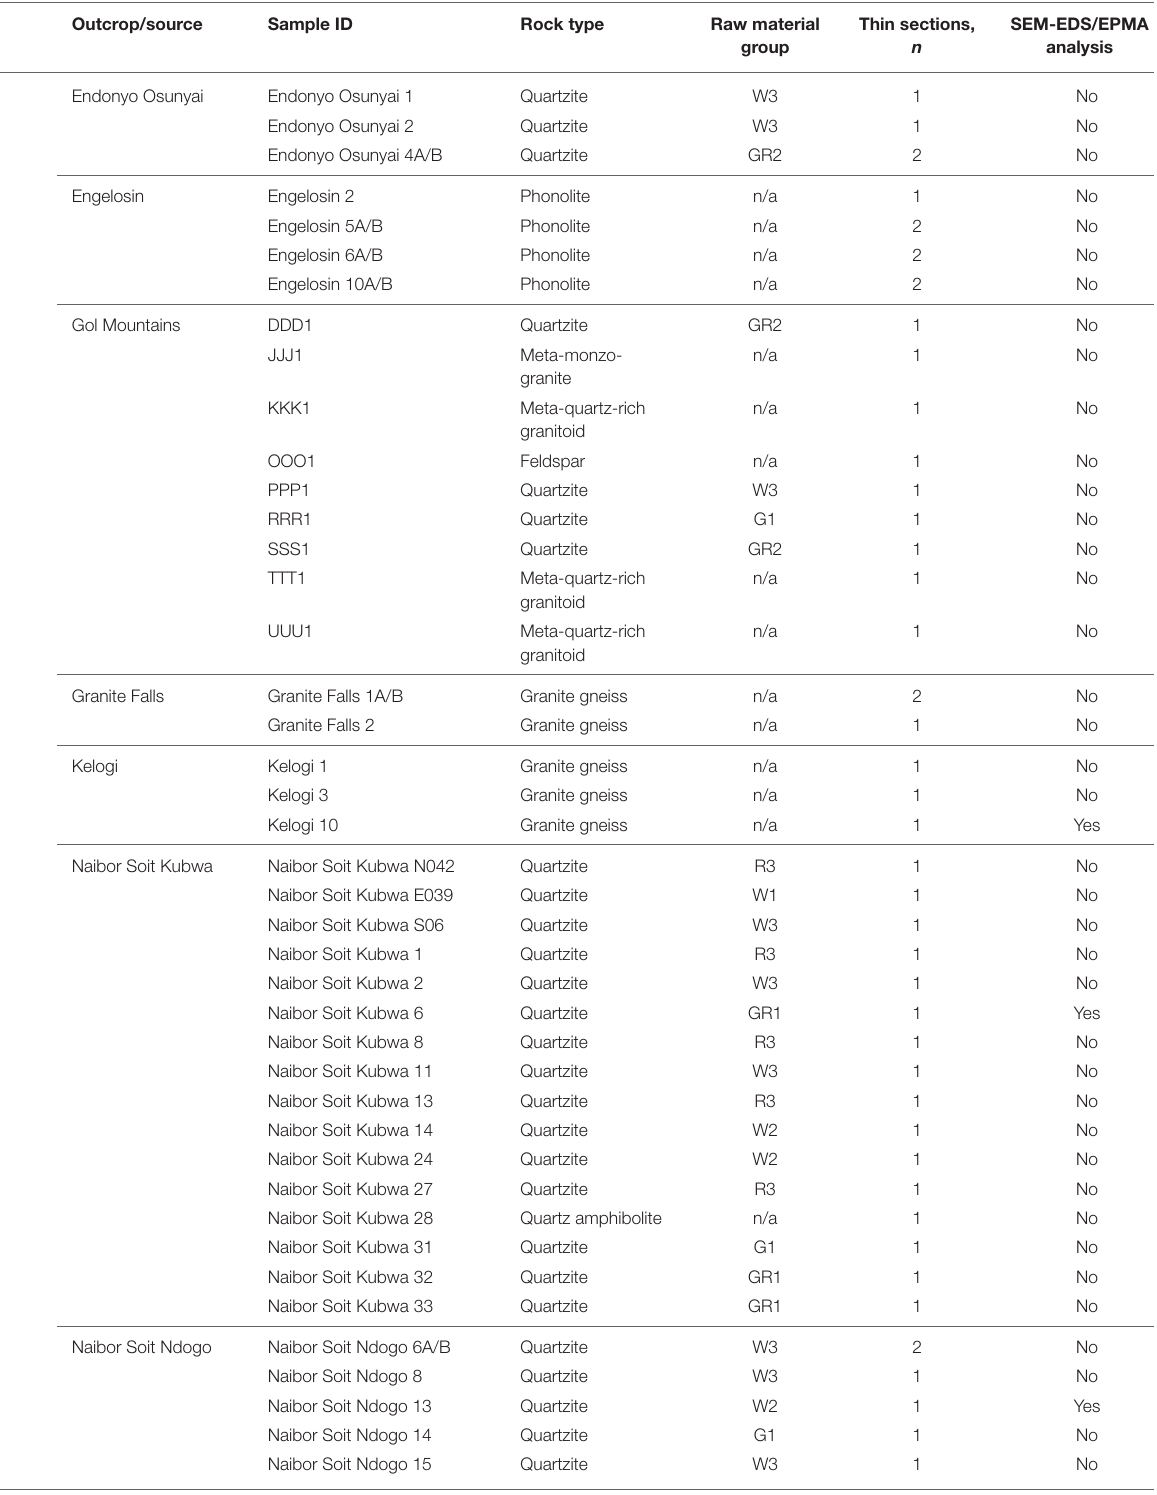
TABLE 1 | Sample position, outcrop/source, ID, rock type, raw material group, number of thin sections per sample, and samples analyzed by SEM-EDS/EPMA.